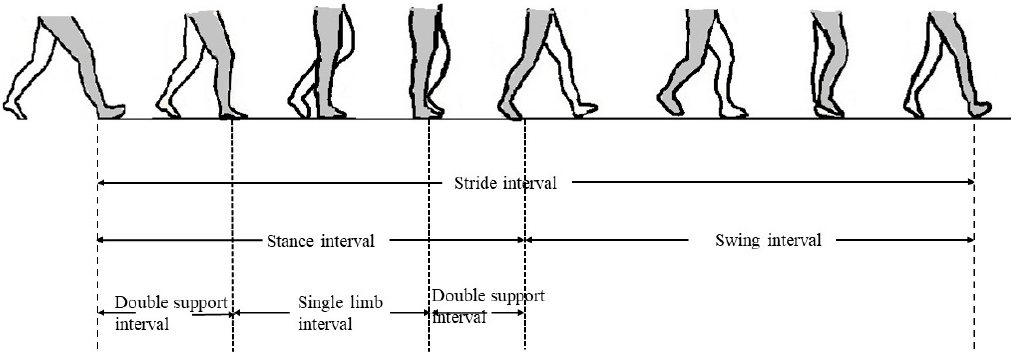
Figure 1. Representation of gait intervals .